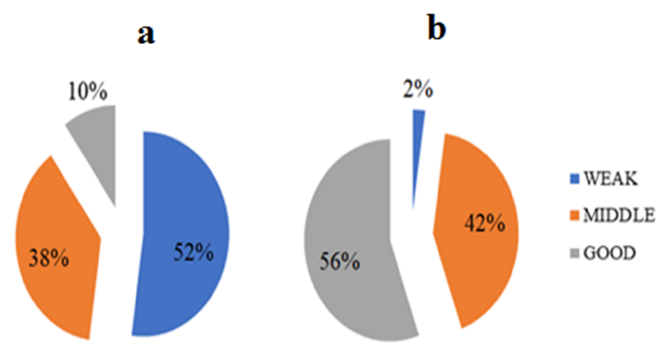
Figure 3. Citizens’ level of awareness ( a ) and performance ( b ).